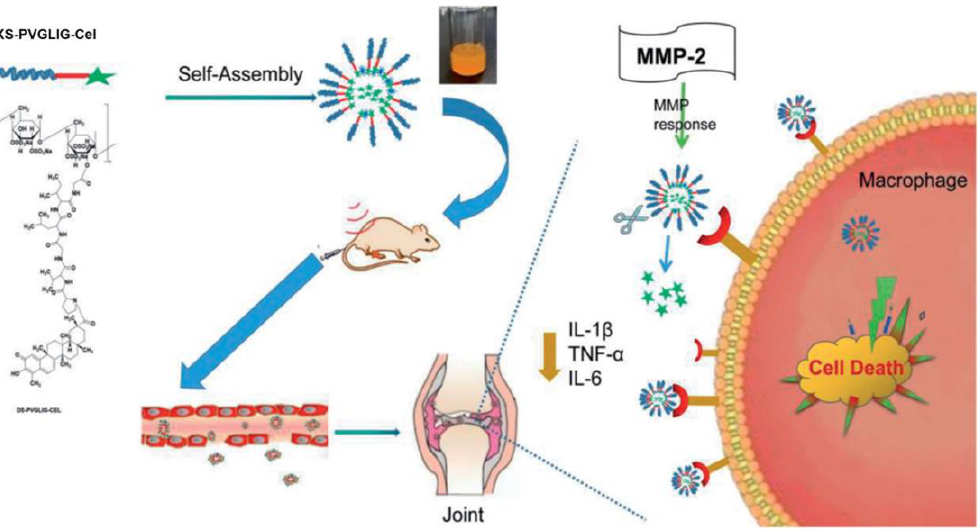
Figure 4. Schematic illustration for the preparation of MMP2-enzyme sensitive DXS-PVGLIG-Cel prodrug micelles and its SR-A mediated targeting for the treatment of RA. Adapted with permission from the ref [53] . Copyright 2022 The authors.